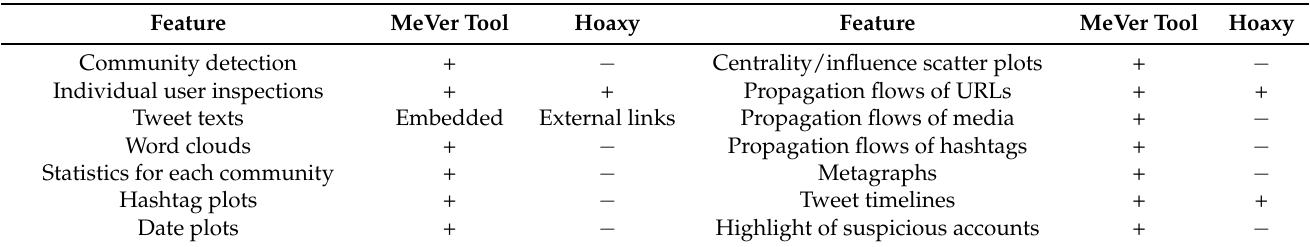
Figure 14. Graphs for hydro use case: ( a ) Hoaxy visualization and ( b ) MeVer NetworkX analysis and visualization. Table 12. Comparison of MeVer NetworkX’s and Hoaxy’s analysis and visualization